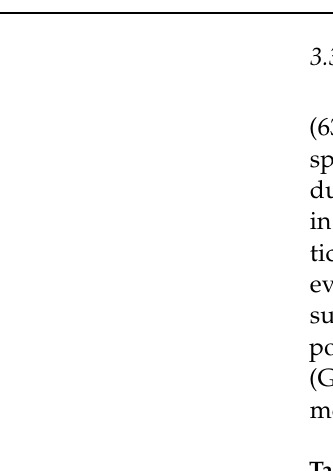
Table 3. Mothers’ activities during the nationwide COVID-19 lockdown